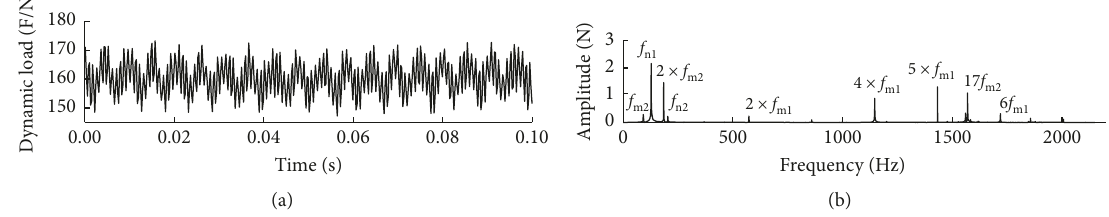
Figure 14: Bearing force with constant stiffness. (a) Dynamic load time history. (b) Dynamic load spectrum.